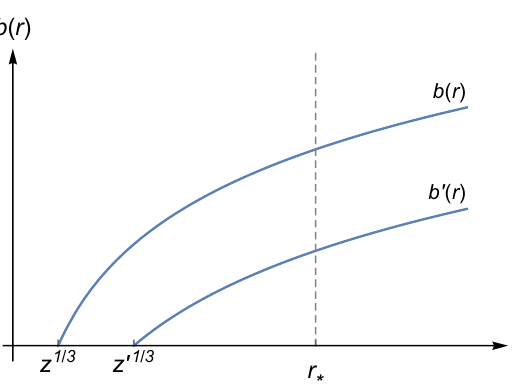
Figure 8 . Two solutions b ( r ) (cid:24) R B 2 to the supergravity equations of motion in the Klebanov- Tseytlin throat. The 4d (cid:13)at direction of the potential corresponds to a change of